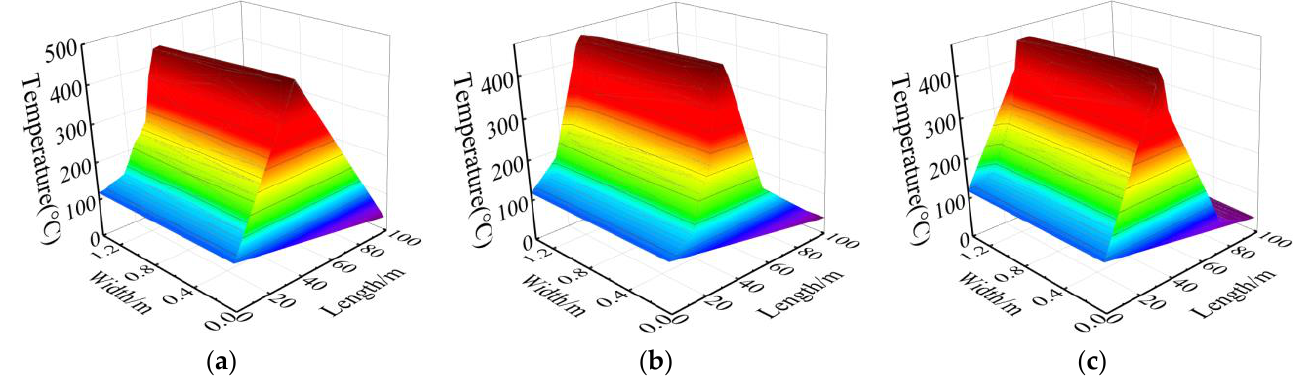
Figure 13. Temperature at different positions in the track bed: ( a ) surface; ( b ) middle; ( c ) bottom.